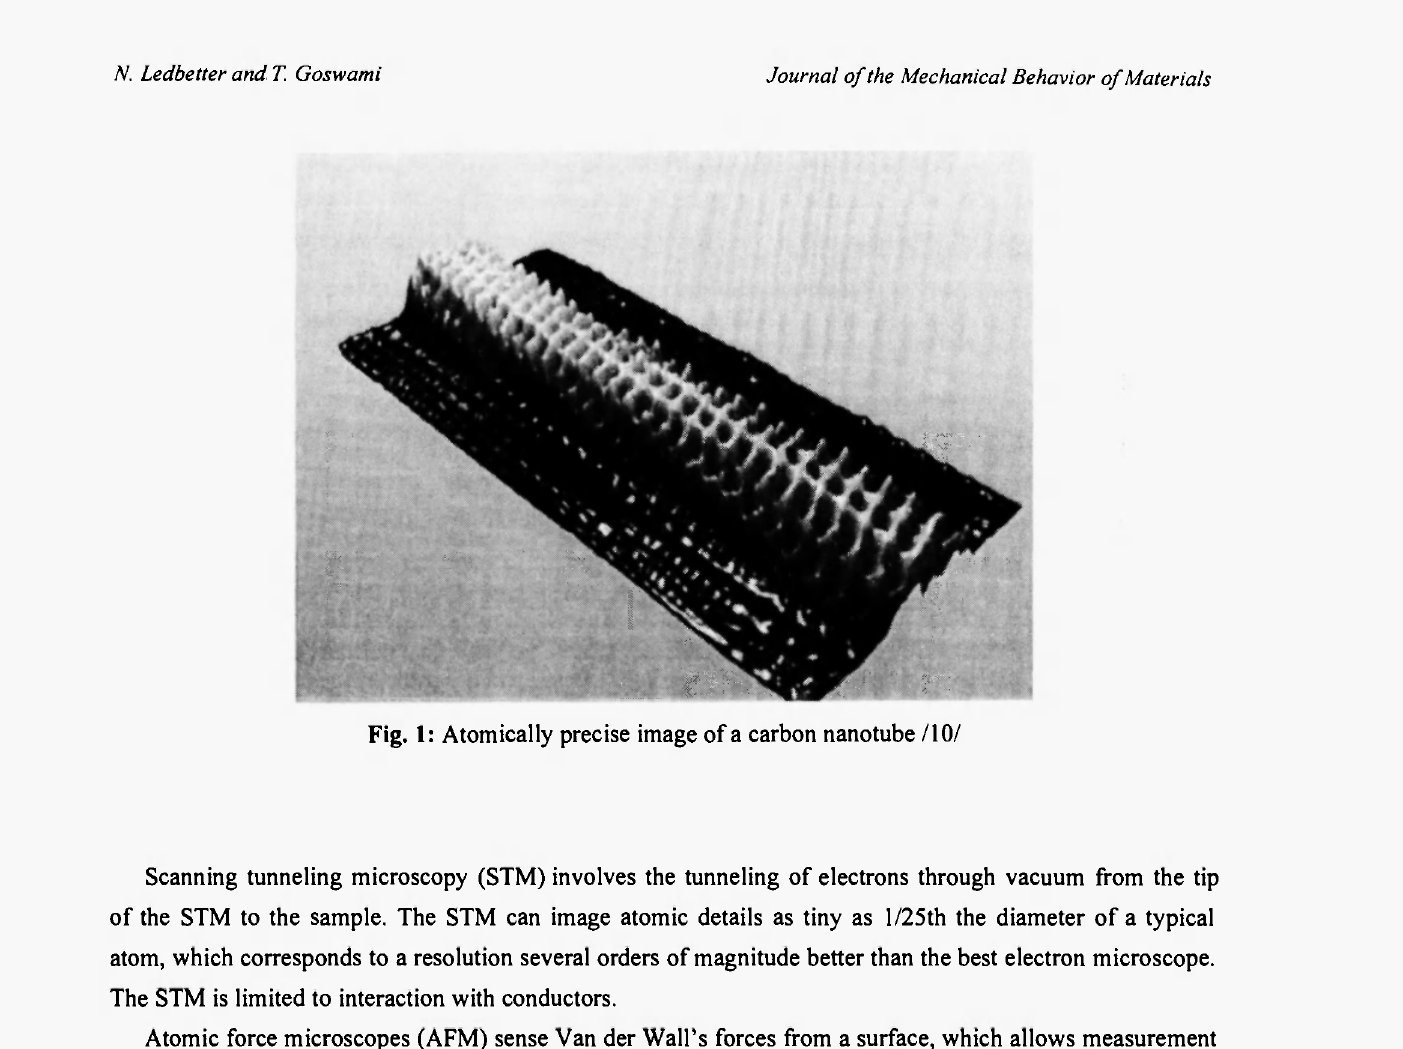
Fig. 1: Atomically precise image of a carbon nanotube